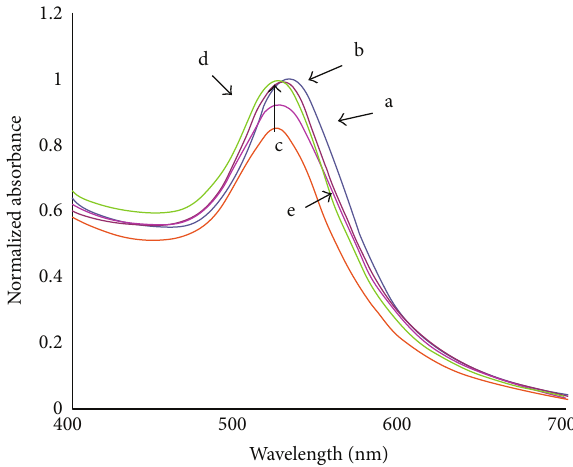
Figure 6: Absorption spectra of AuNPs with various concentrations of reducing agent MSG: (a) 100mM; (b) 150 mM; (c) 200 mM; (d) 250 mM; (e) 300 mM.